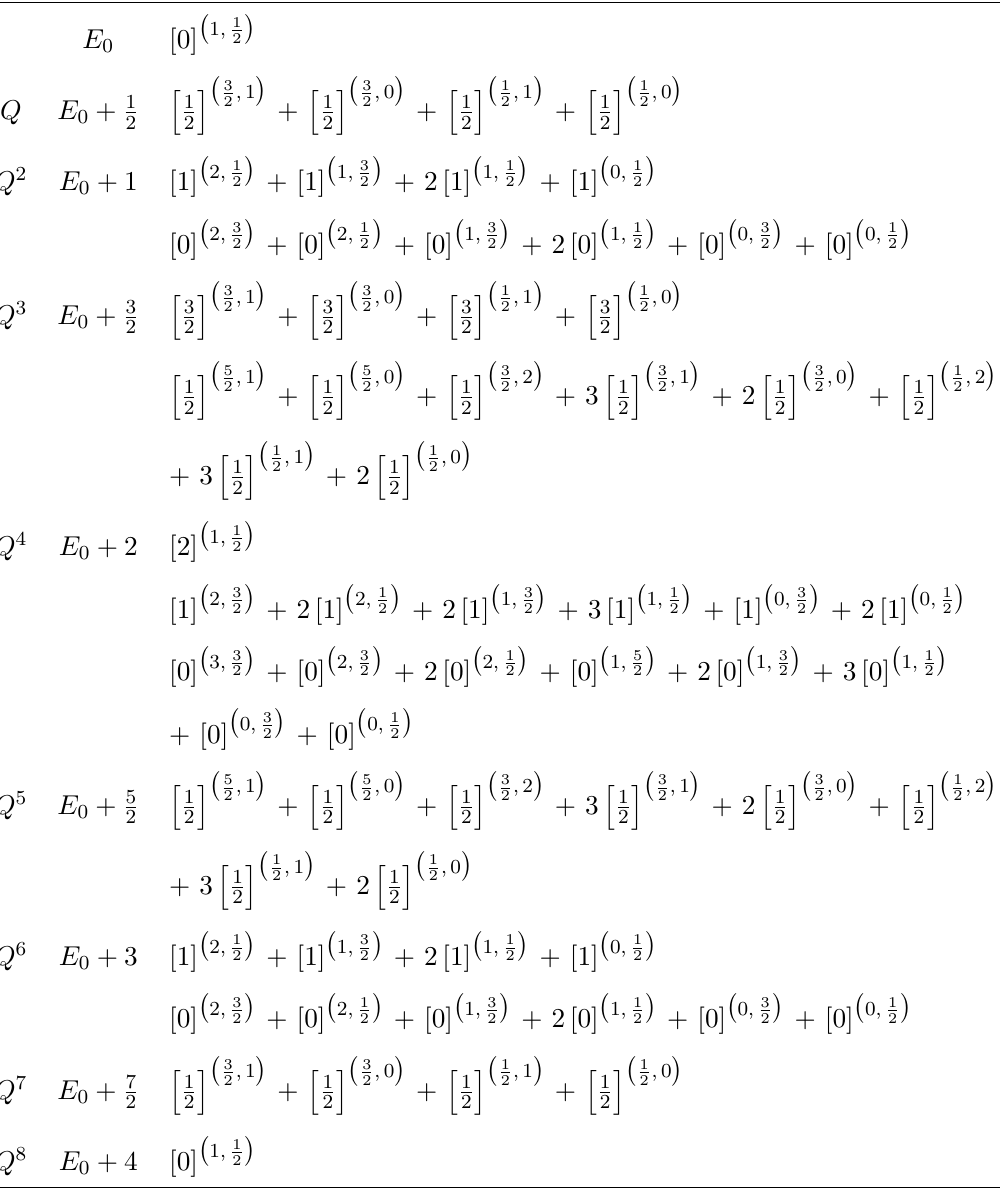
Table 7 . States in the long graviton supermultiplet LGRAV 4